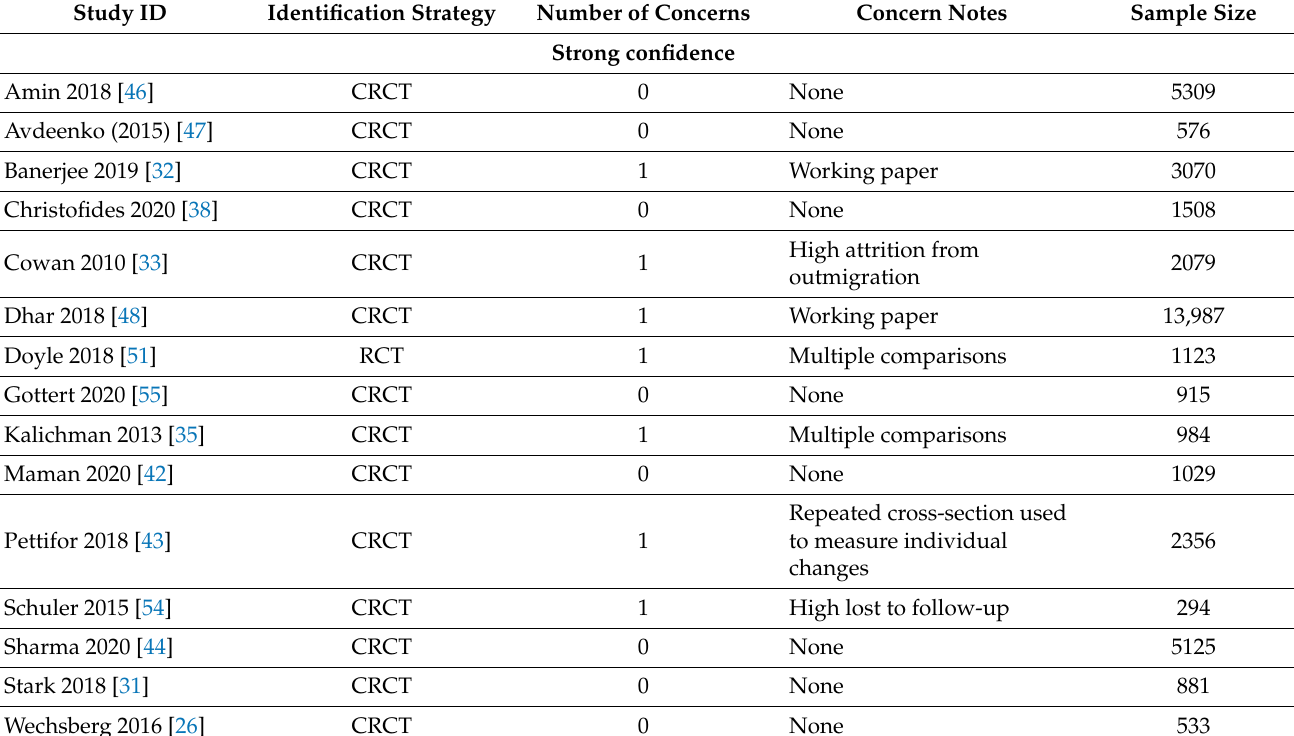
Table 2. Confidence-in-findings appraisal and sample size for behavioral outcome of primary